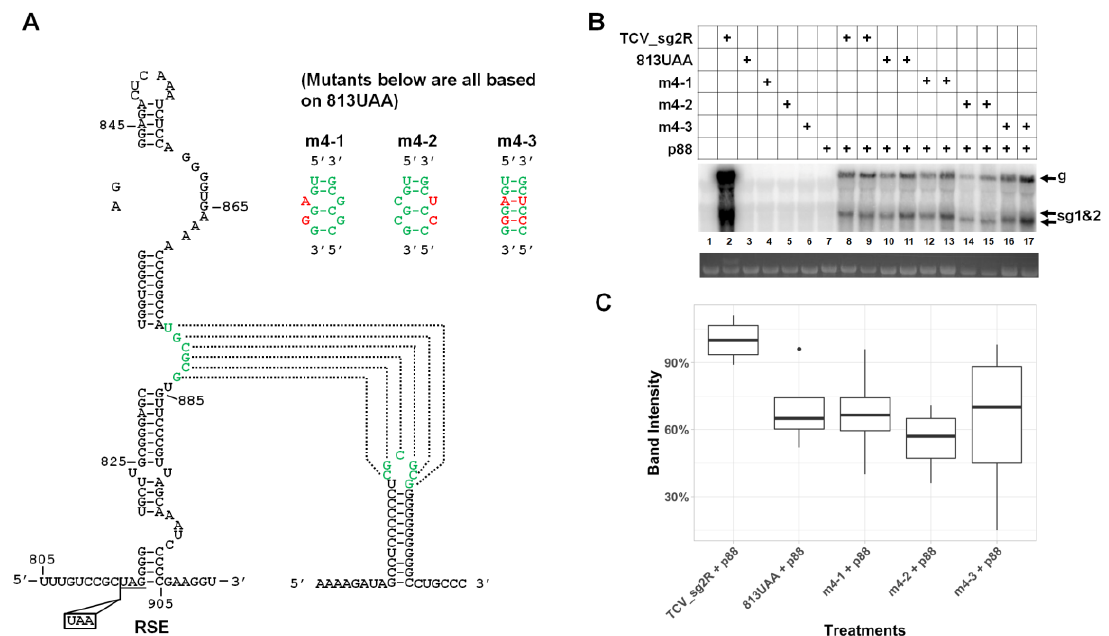
Figure 4. The long-distance kissing-loop interaction does not have a read-through-independent role in TCV gRNA accumulation. ( A ) Diagrams depicting the kissing-loop interaction between the asymmetric loop in RSE and the end loop of the 3′ terminal stem – loop of TCV gRNA, and the mutants tested in this set of experiments. The specific nt changes in these mutants are identical to those in a previous study (see text for details). ( B ) A representative Northern blotting showing accumulation levels of the mutants. ( C ) Box plot quantification of Northern blotting results.